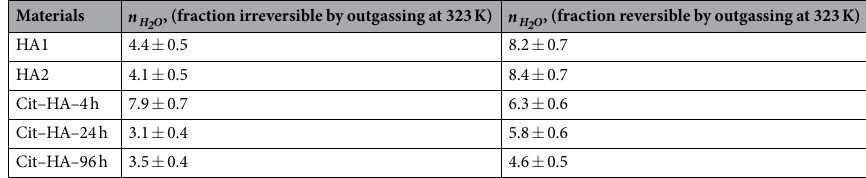
(given as water molecules per nm 2 ) for the two hydration conditions